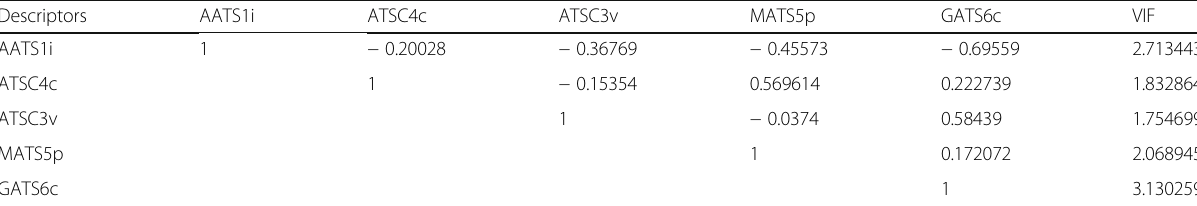
Table 8 Correlation matrix of the descriptors from the built model 1